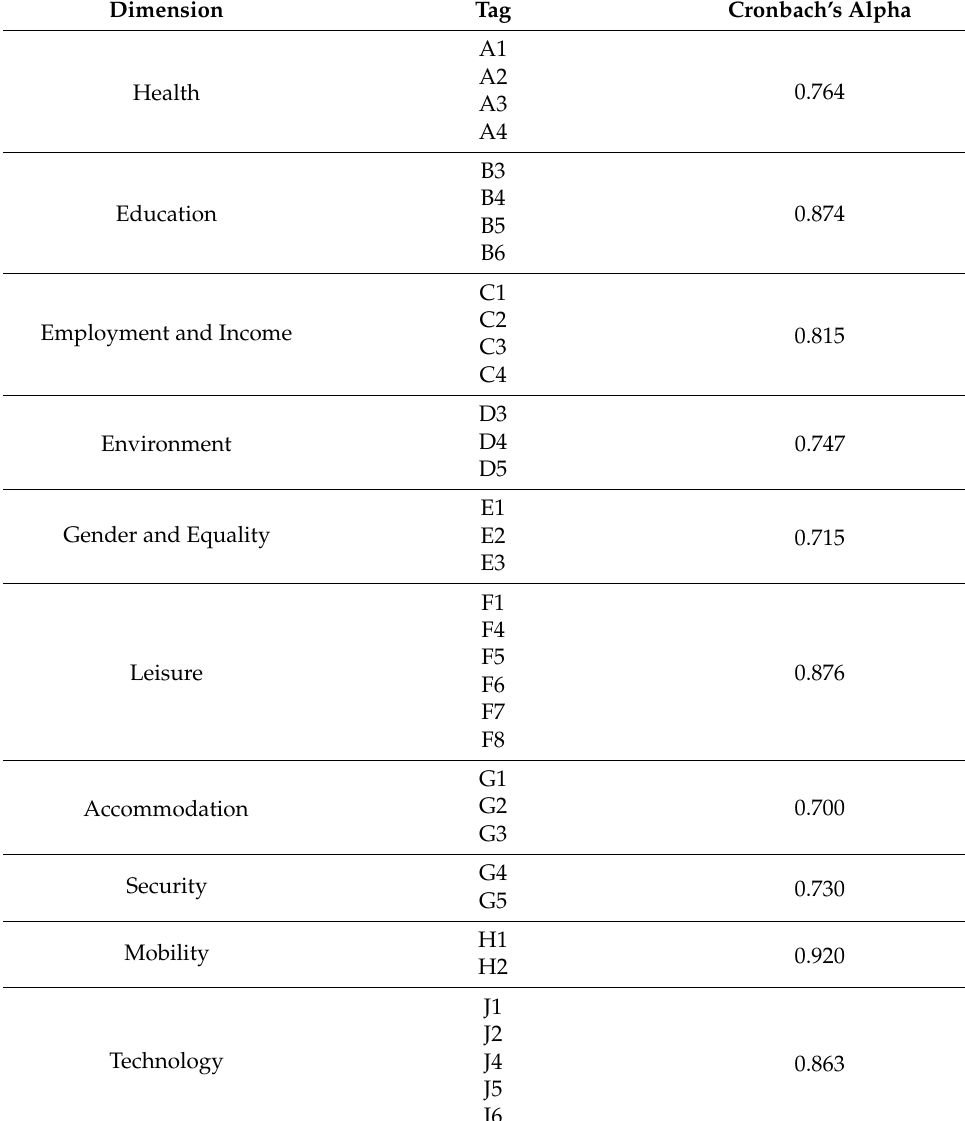
Table A1. Internal reliability (Cronbach’s